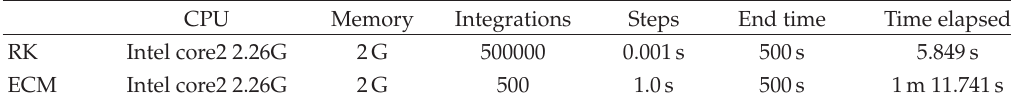
Table 2: Comparison of computing e ffi